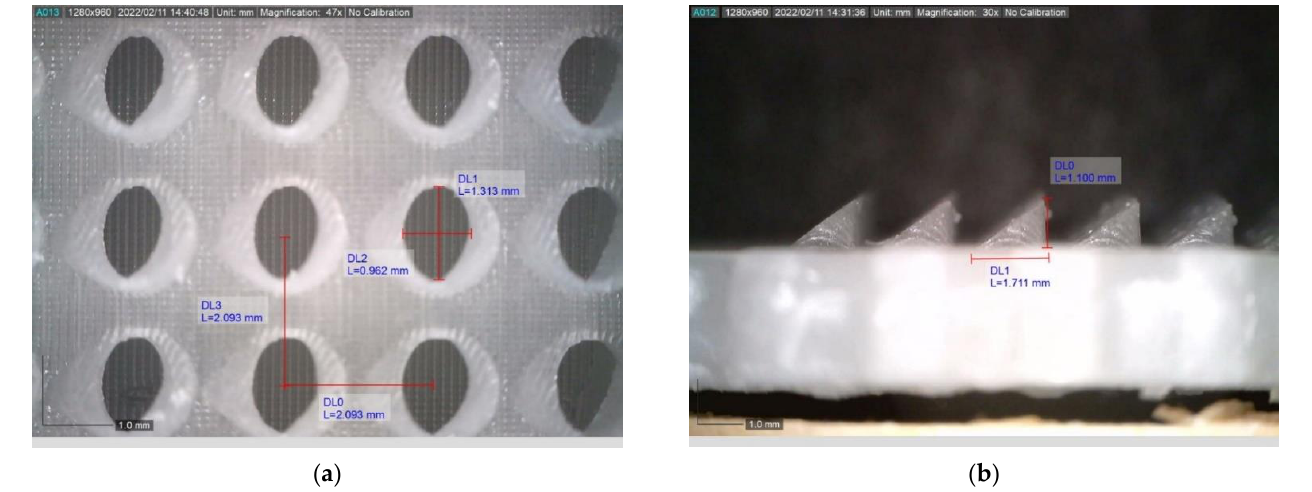
Figure 14. ( a ) Top view and ( b ) side view of the microneedles 3D printed with a liquid crystal display technique.